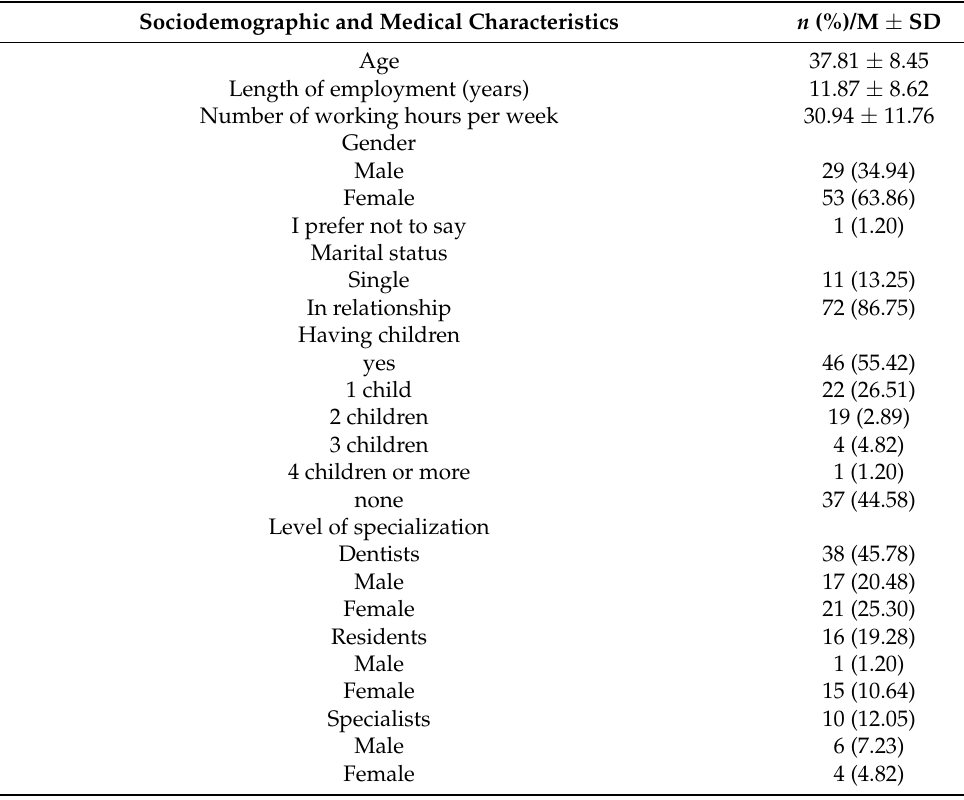
Table 1. Sociodemographic and medical characteristics 1